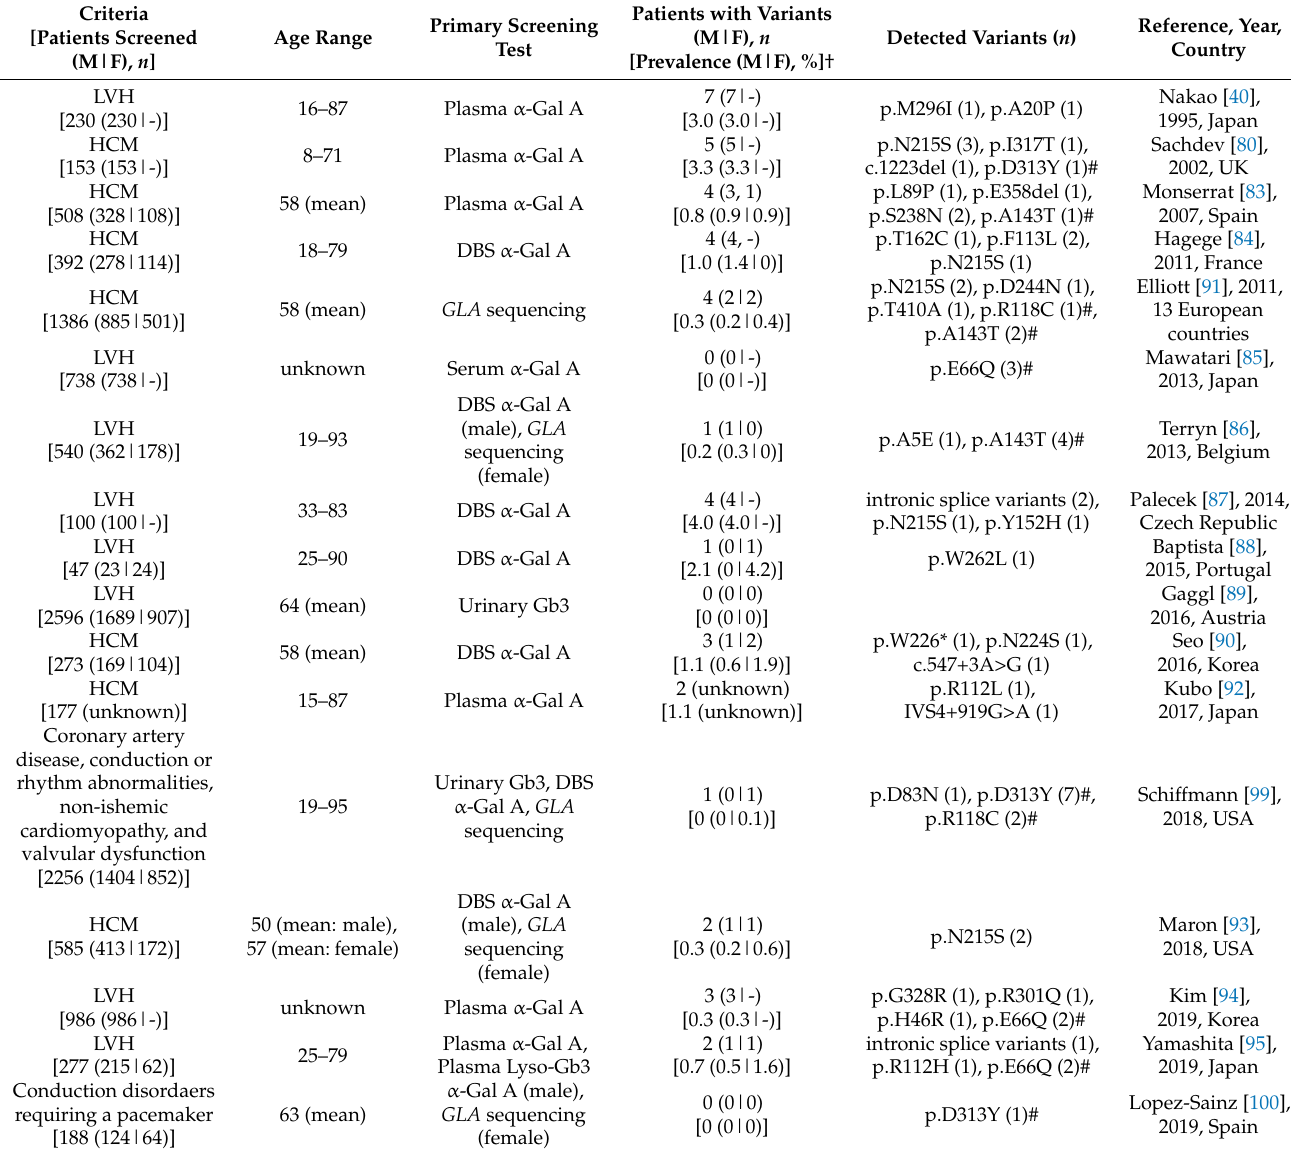
Table 2. Previous high-risk screening for FD in individuals with cardiac manifestations. Criteria Patients with Variants Primary Screening [Patients Screened (M|F), n Detected Variants ( n Test [Prevalence (M|F), %] †